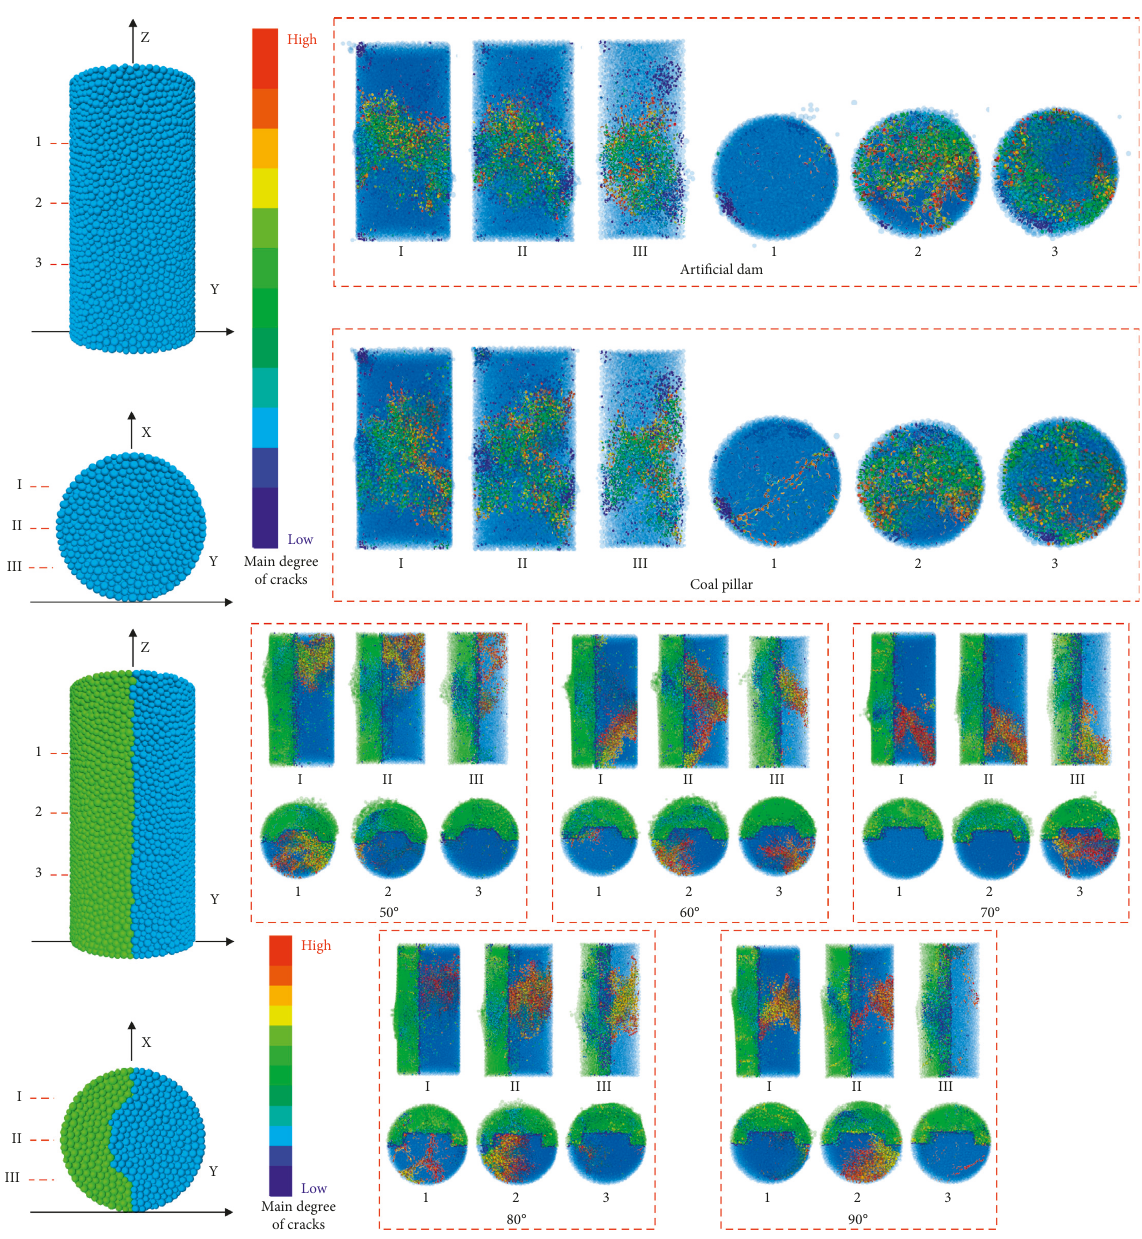
Figure 19: Numerical simulation of the spatial distribution of